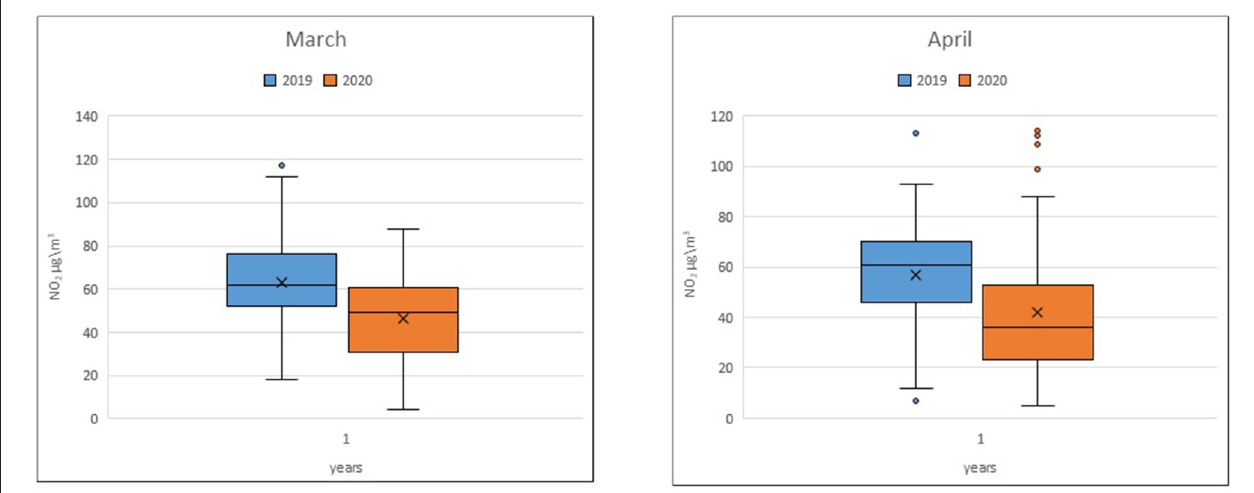
FIGURE 1 | NO 2 monthly average at the traffic